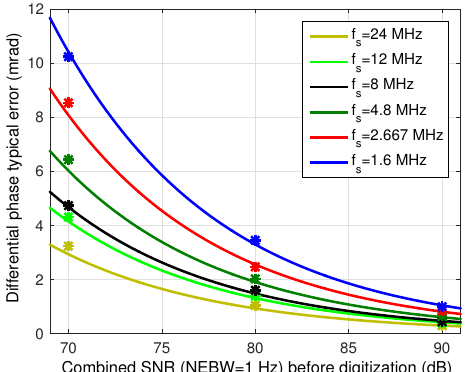
Figure 10. Phase error ( σ ) as a function of input SNR ( SNR 0 ) and sampling frequency ( f s ) . Estimated and measured results.